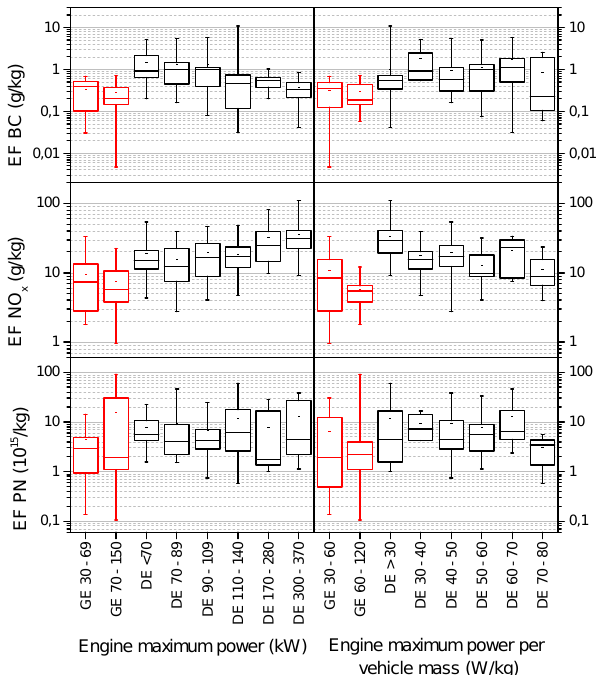
Figure 4. BC, NO x and PN Efs according to engine power (left) and power per mass (right); red boxes present gasoline engines (GE) and black boxes present all diesel engines (DE) regardless of their vehicle category. Note the EFs are on logarithmic scale; same figure in linear scale can be found in Supplement Fig.